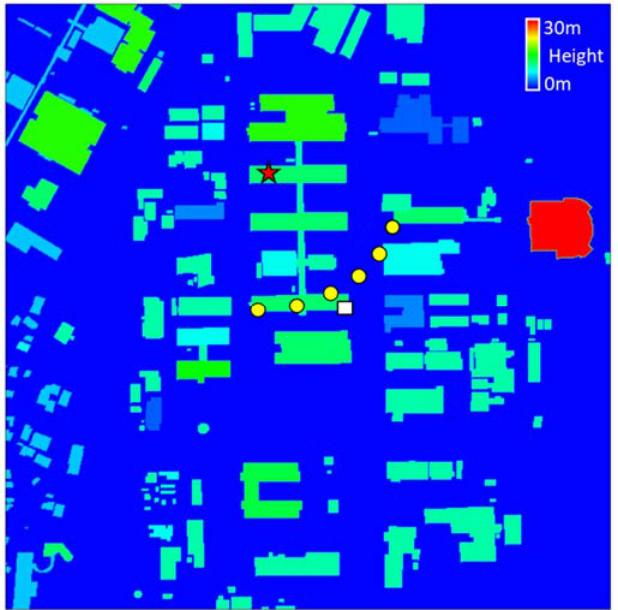
Figure 6. Spatial distributions of building heights in the site of JAEA represented using the digital surface model dataset. The symbols of the red star and the white square are the same as in Figure 1. The yellow circles are measurement points of the Doppler LiDAR at elevation angle of 21.8° used for estimating the reference meteorological condition.